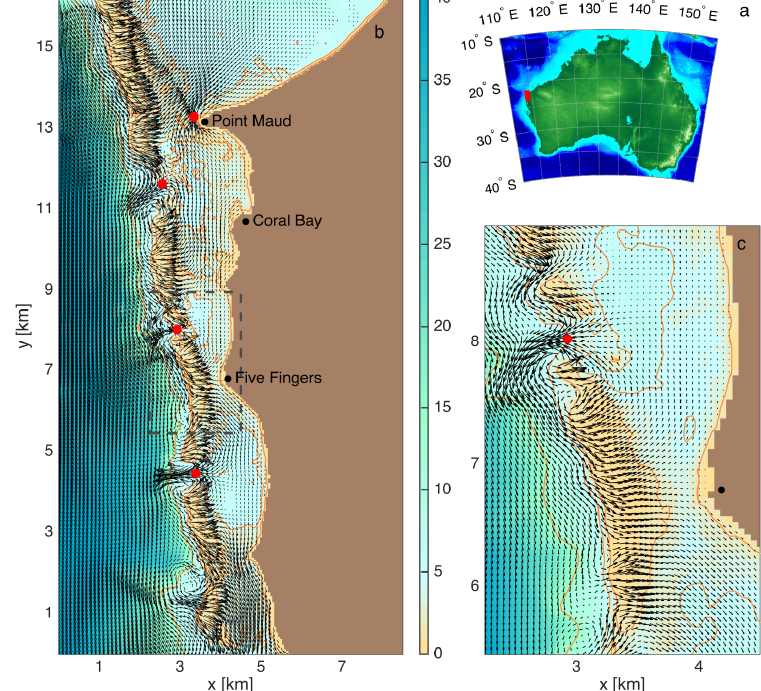
Figure 1. Overview of the Coral Bay study site within Ningaloo Reef. ( a ) The red box denotes the location of the Ningaloo Reef on the west coast of Australia. ( b ) The background color map denotes the bathymetry (in meters), with orange lines highlighting the 2, 4, and 10 m isobaths. The arrows show a snapshot of the time-varying, depth-averaged velocity field obtained by a simulation run with the default forcing (see Methods). Shoreward currents over the reef flat are generated on the outer reef edge by wave breaking, and water recirculates back through relatively narrow channels in the reef, centered at the red dots. Key locations are Point Maud, Coral Bay, and Five Fingers, referred to in the text. ( c ) A zoom of the area in ( b ) is marked by the dashed line.